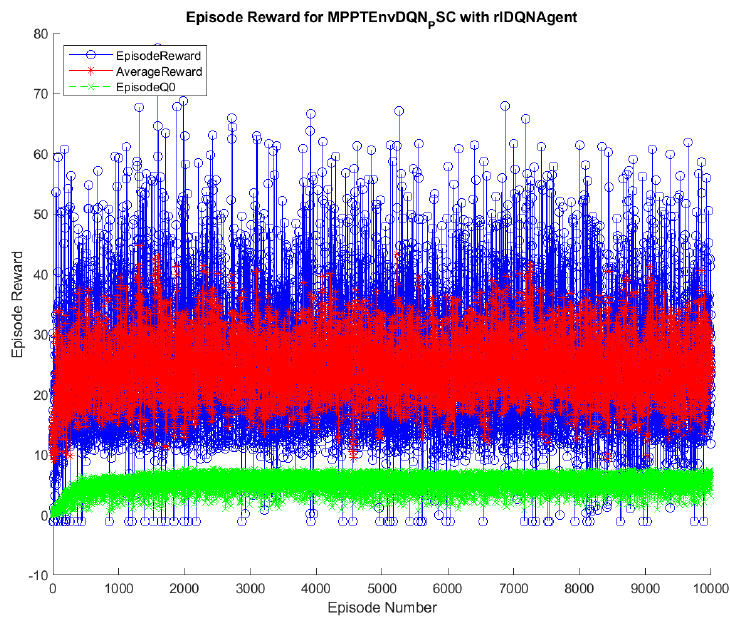
Figure 4. Training process of the DQN method.